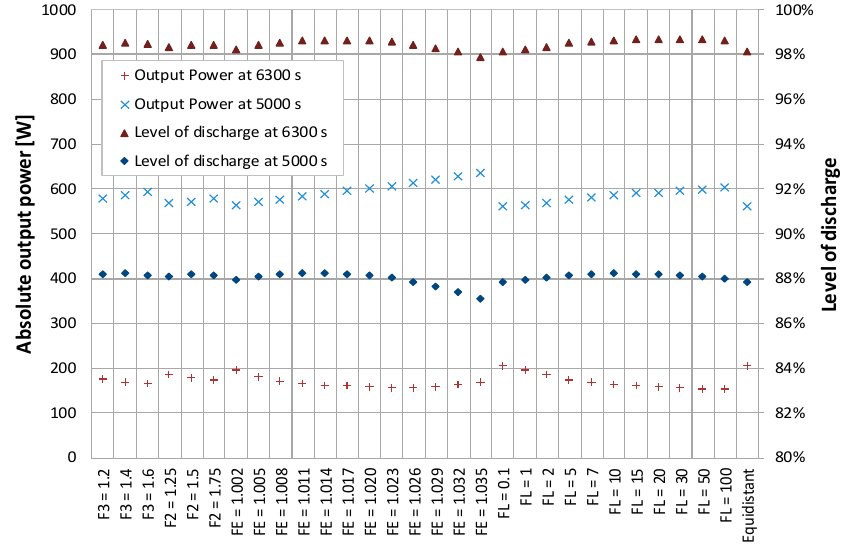
Figure 7. Comparison of absolute output power and level of discharge at 5000 s and 6300 s for all allocations.